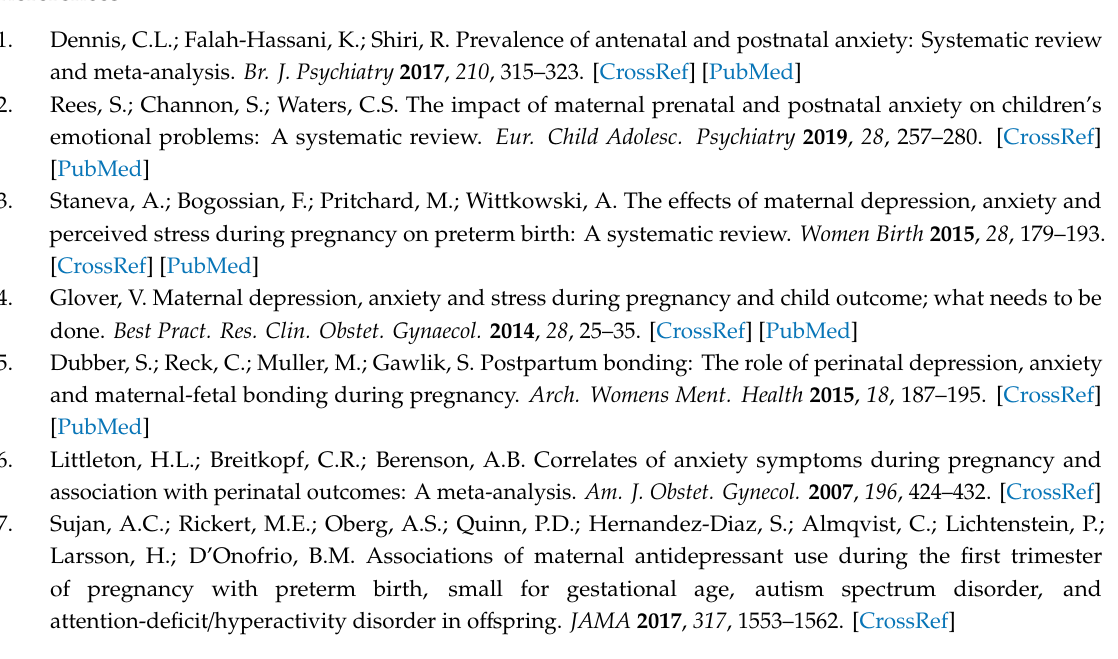
Table S1: PRISMA checklist, Table S2: Search strategy, Table S3: Revised Cochrane risk-of-bias tool (RoB 2.0) for quality assessment of included RCTs, Figure S1: Sensitivity analyses of music interventions on anxiety in pregnant women by omitting each study, Figure S2: Forest plot of pooled anxiety scores after the intervention, comparing the music group and the control group (subgroup analysis by the music type), Figure S3: The Funnel plot of the standard error by standardized mean di ff erence of the studies included in the